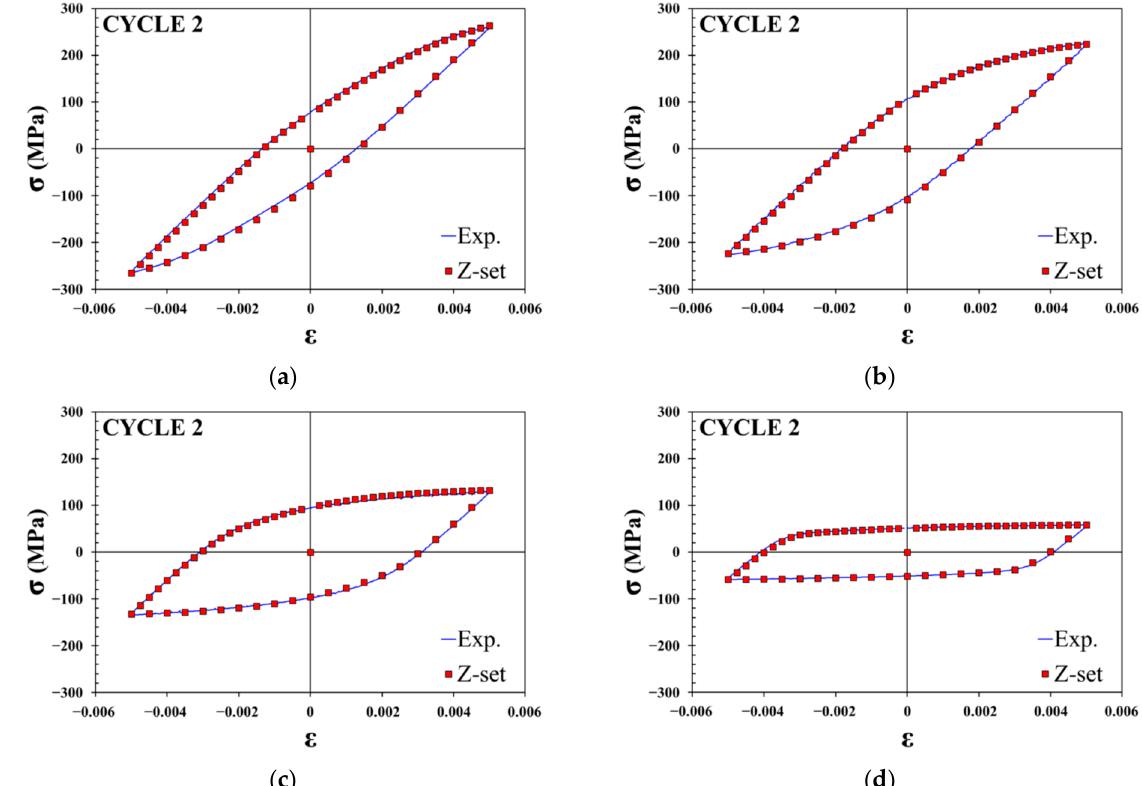
Figure 5. Cycle 2 of LCF strain–stress hysteresis loops with associated Z-set simulation for ( a ) T7 condition at room temperature, ( b ) T7 condition at 200 °C, ( c ) T7S condition at room temperature, and ( d ) T7S condition at 300 °C. Table 3. Elastic and LM&C parameters used for modelling the mechanical behavior of